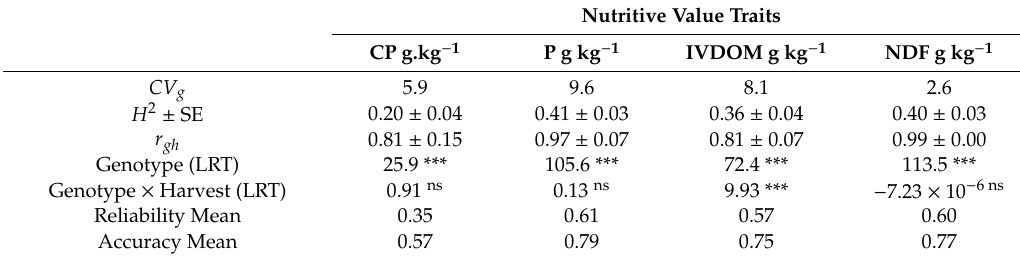
Table 1. Genetic parameters for the United States Department of Agriculture National Plant Germplasm System (USDA-NPGS) bermudagrass germplasm collection evaluated in Citra, FL. Genetic coe ffi cient of variation ( CV g ), broad sense heritability ( H 2 ± SE), and genotype by harvest correlation ( r gh ) for crude protein (CP), phosphorous (P), In Vitro Organic Matter Digestibility (IVDOM), and Nutrient Detergent Fiber (NDF) expressed at grams per kilogram. Likelihood Ratio Test of Genotype and Genotype by Harvest, Reliability Mean, and Accuracy Mean for nutritive value (NV) traits.